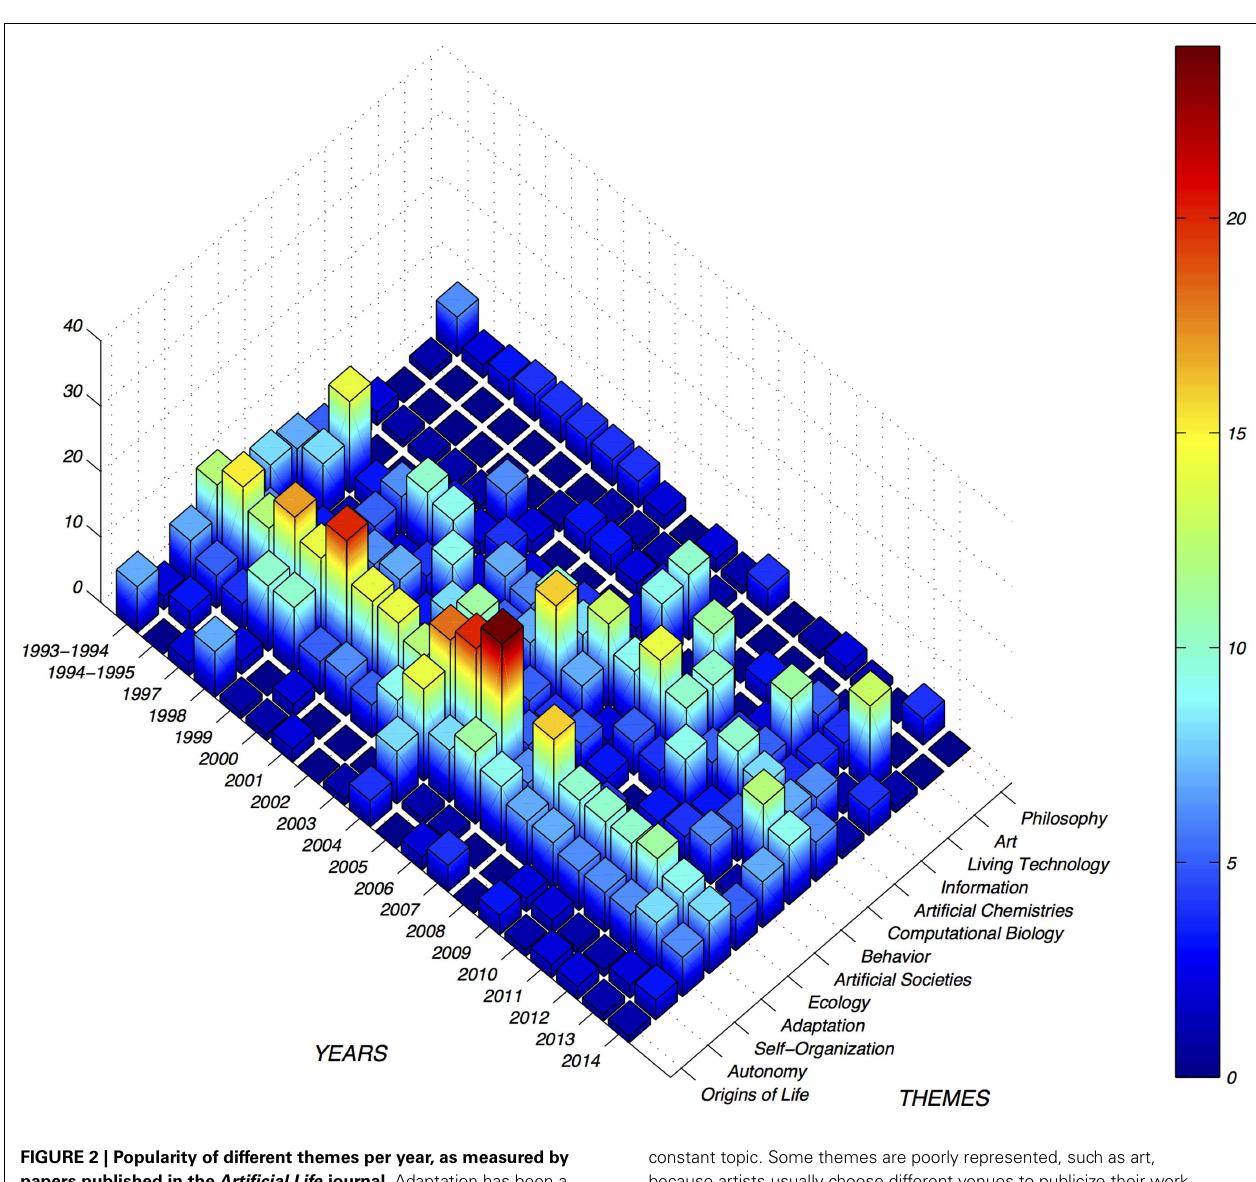
constant topic. Some themes are poorly represented, such as art, because artists usually choose different venues to publicize their work. Other themes have had peaks of popularity for different reasons, such as special